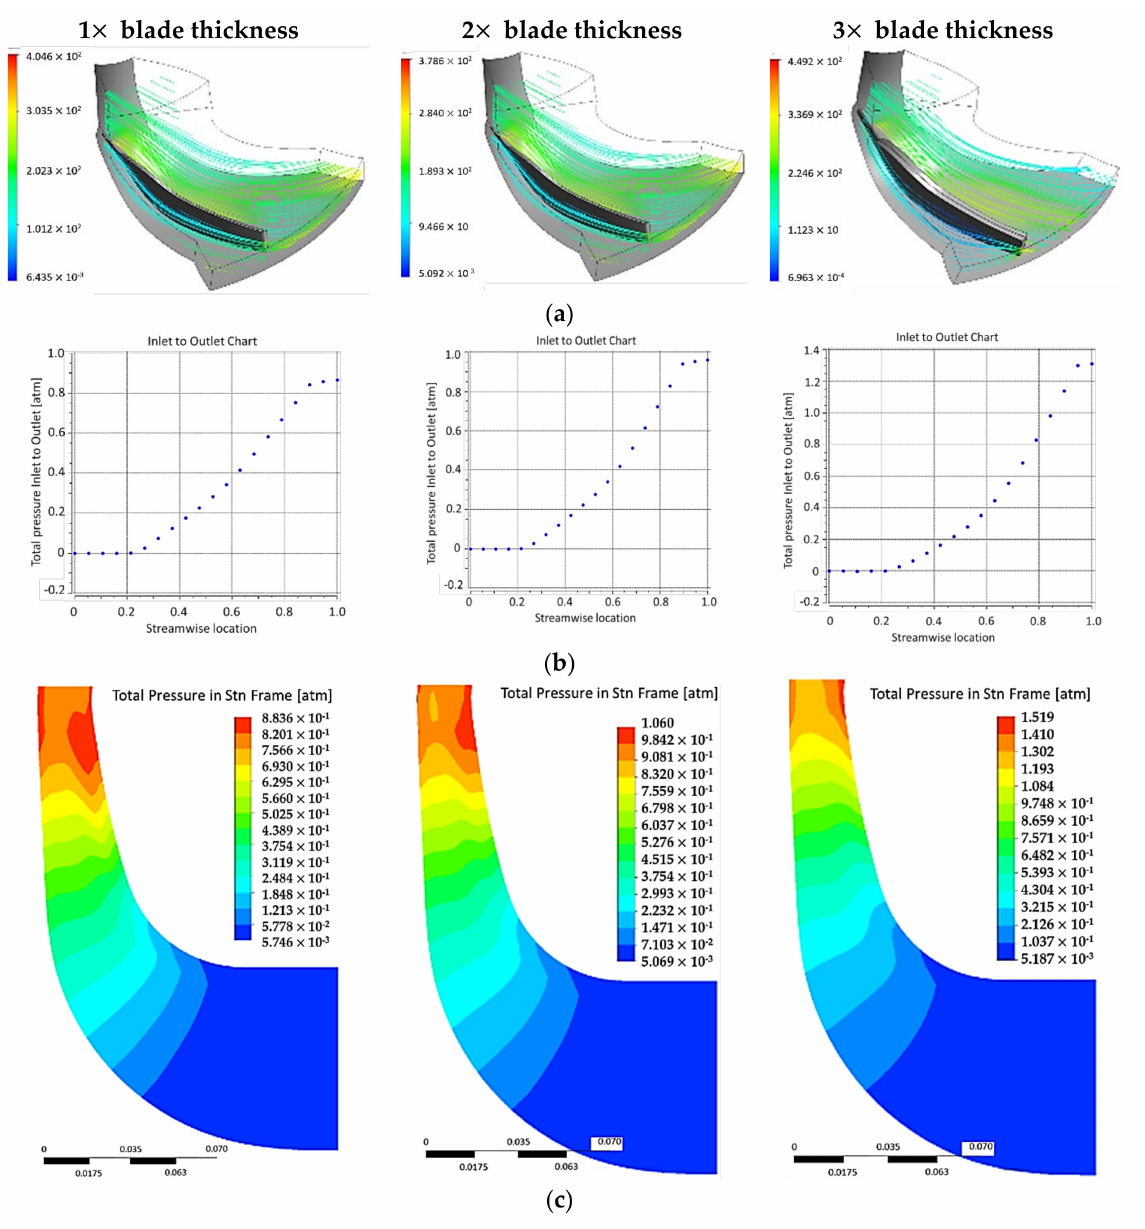
Figure 7. Analyses results presenting ( a ) stream lines; ( b ) pressure variation from inlet to outlet and ( c ) pressure variation in meridional plane, for the impeller case with 7 blades. Table 4. Scores obtained for calculated